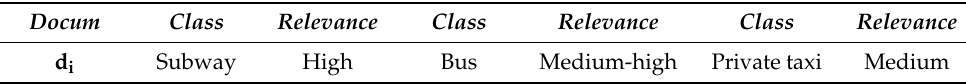
Table 2. Example of classification of a